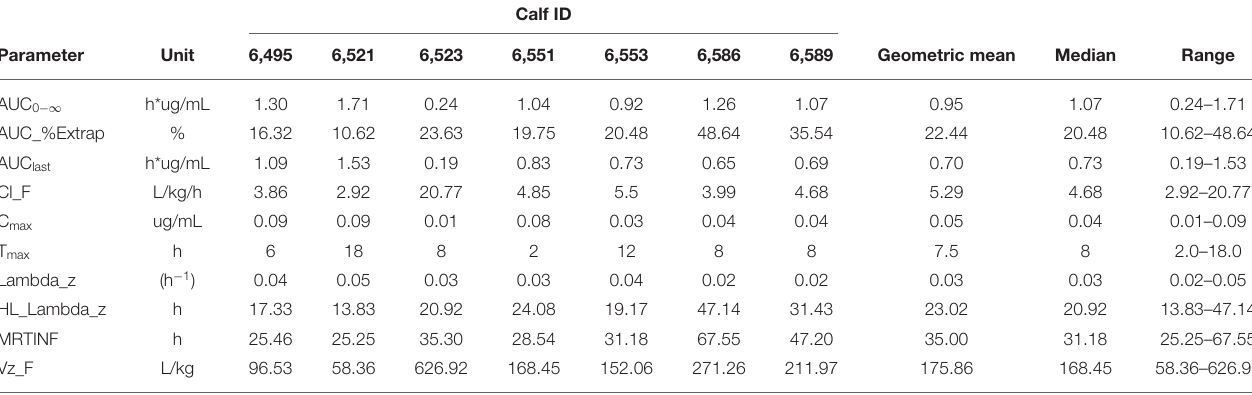
TABLE 1 | Individual animal and geometric mean pharmacokinetic parameters of cannabidol (CBD) following oral administration at 5 mg/kg.